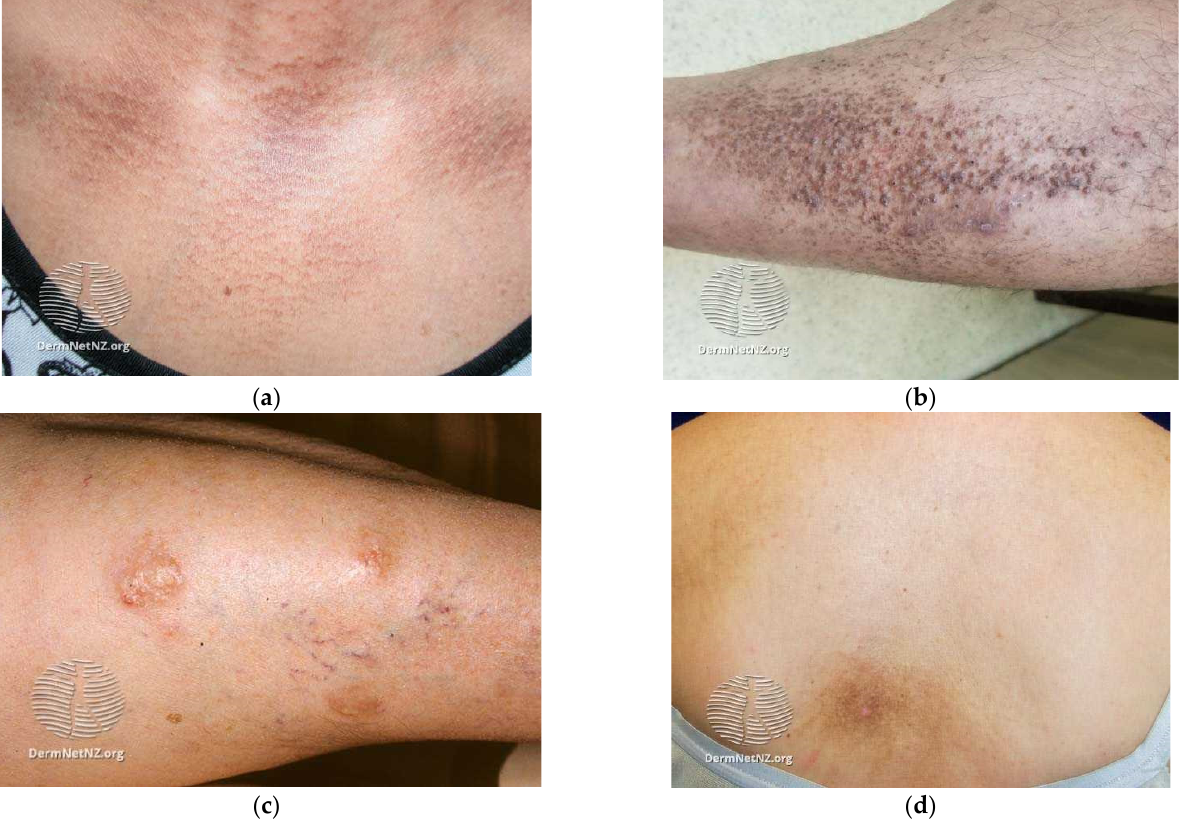
Figure 1. Typical examples of primary localized cutaneous amyloidosis: ( a ) macular amyloidosis; ( b ) lichen amyloidosis; ( c ) nodular amyloidosis; ( d ) area of notalgia paraesthetica in macular amyloidosis. Available from dermnetnz.org (accessed on 13 February 2023), a free dermatology resource.